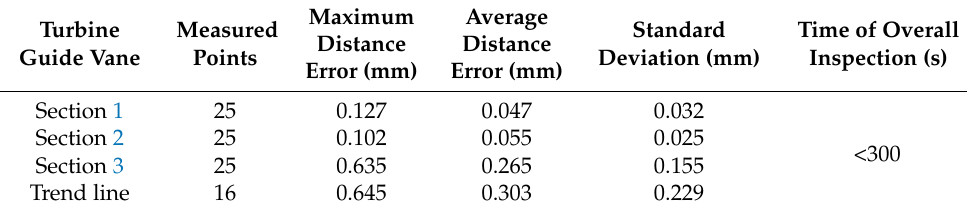
Table 3. Profile measurements of turbine guide